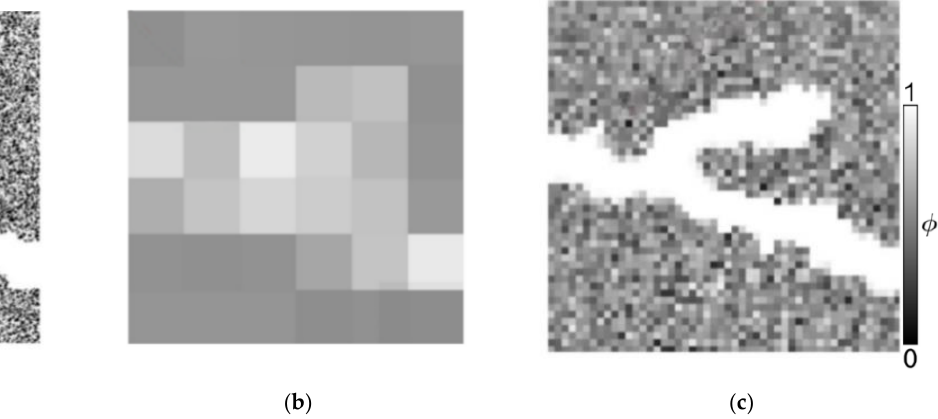
Figure 1. Three solution strategies for flow problems in porous media. ( a ) Pore–scale simulation based on N-S equation; ( b ) Continuous scale simulation based on Darcy’s law; ( c ) Hybrid simulations.